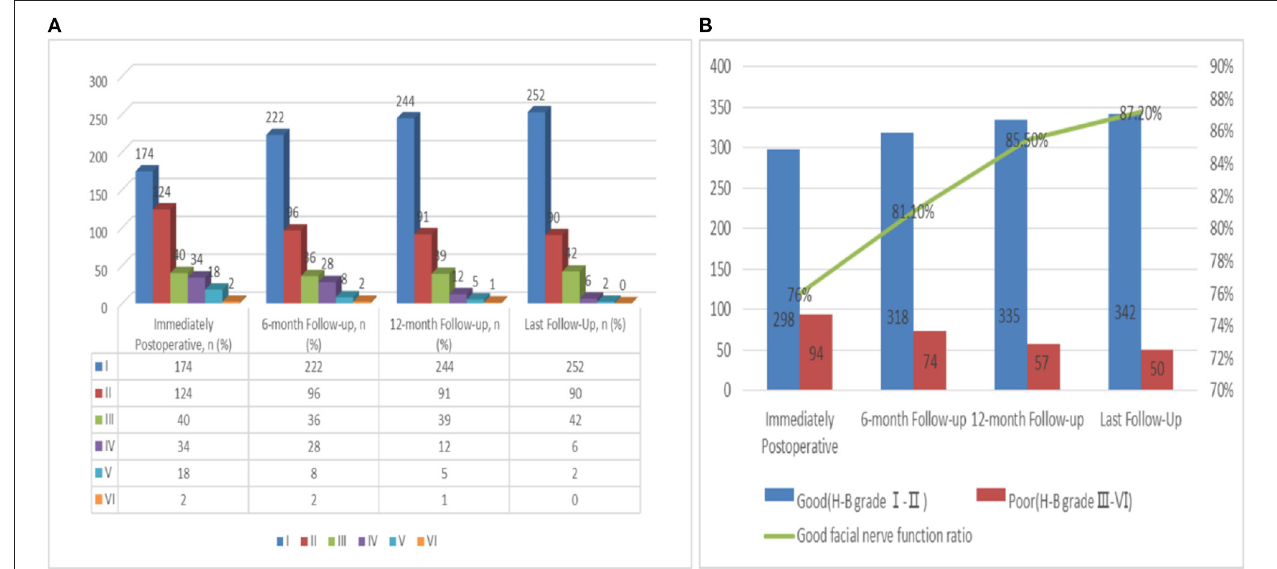
FIGURE 4 | (A) Follow up of FN functional recovery; (B) Change trend of the recovery rate of FN function with follow-up